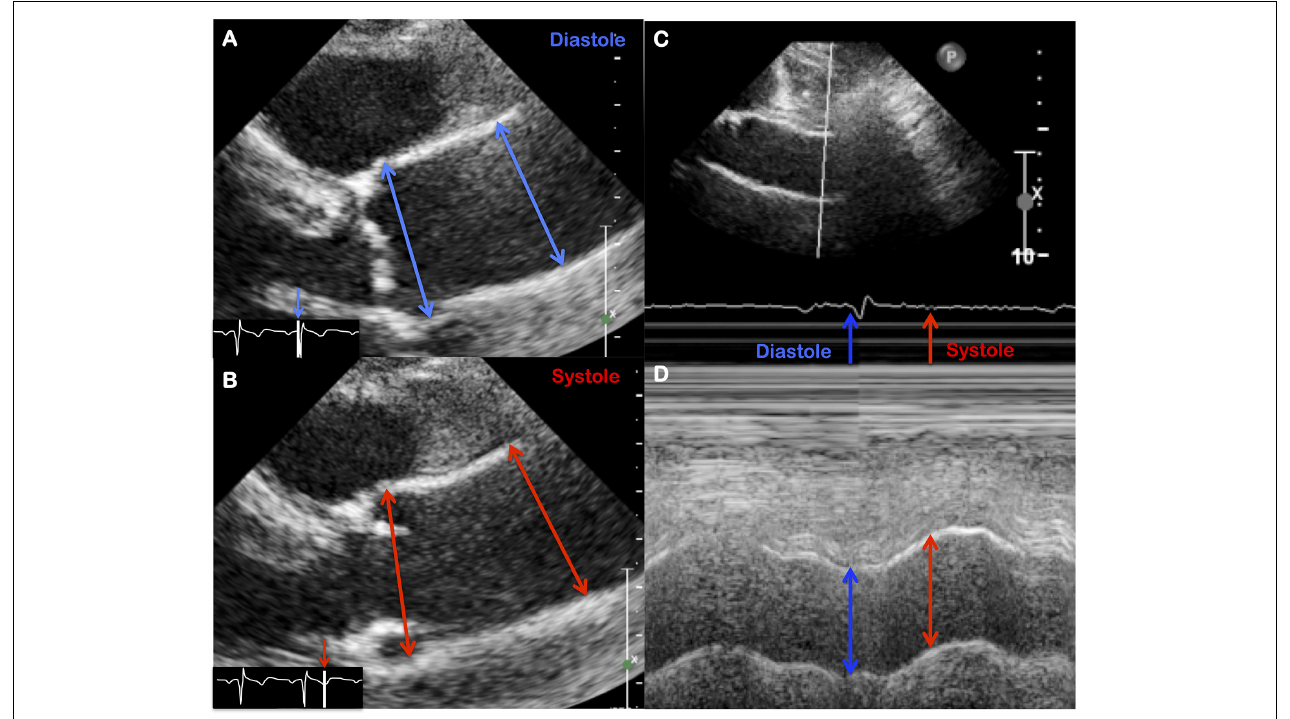
FIGURE 2 | Evaluation of aortic strain using echocardiographic features, either with B mode (A,B) or with M mode (C,D) .